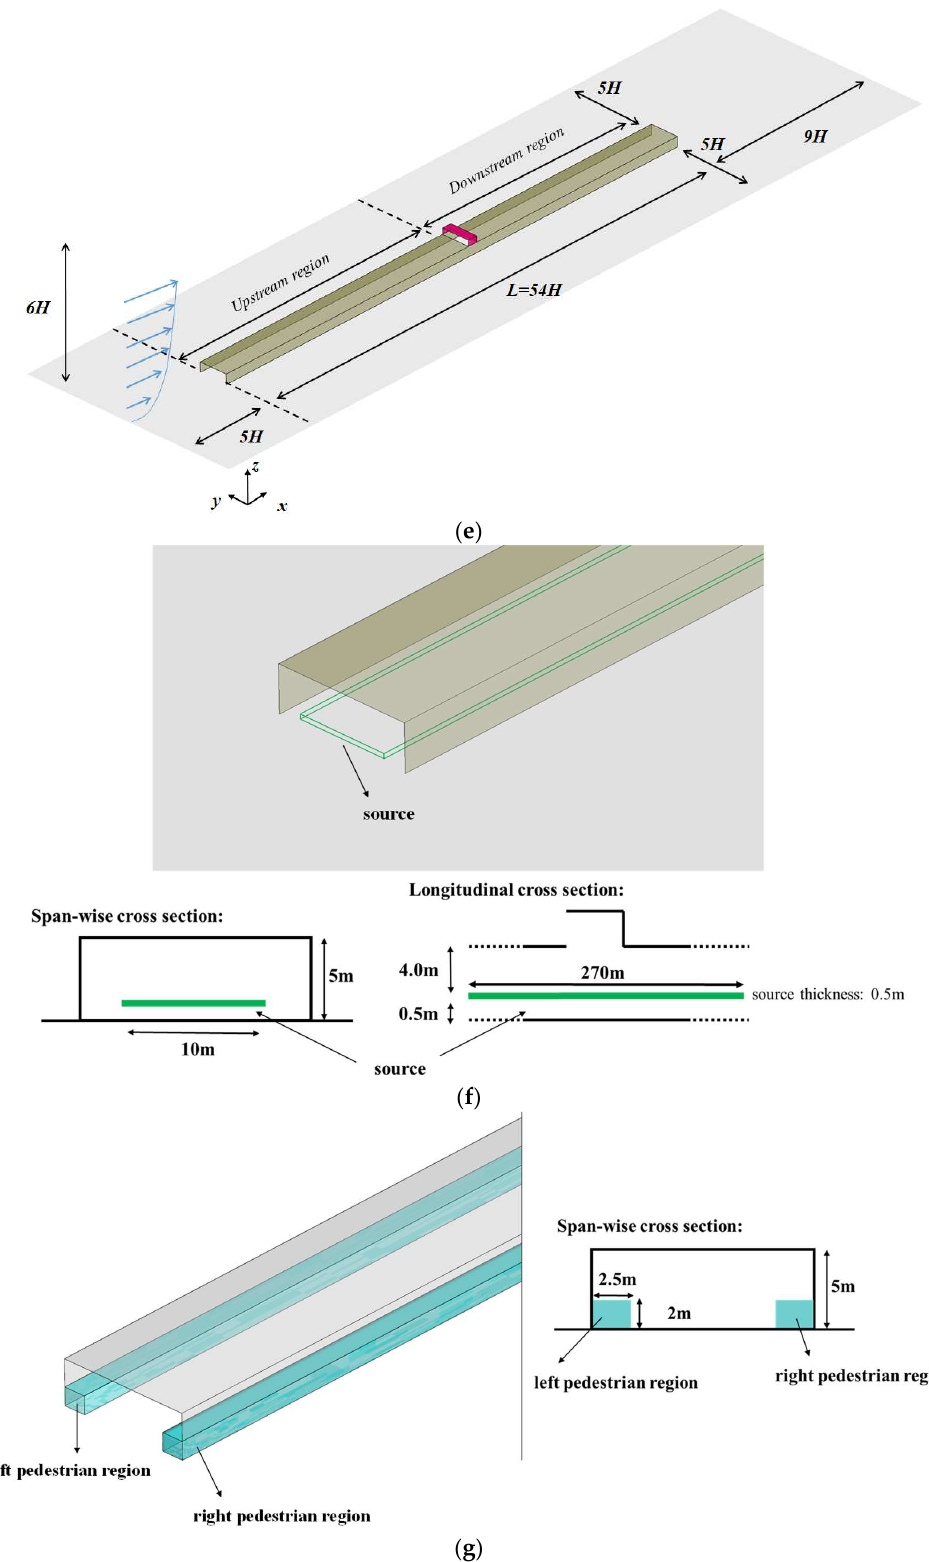
Figure 2. ( a ) Physical model and boundary condition setups in tunnel-catcher simulation cases. Model and grid distribution of ( b ) single long-catcher cases; ( c ) single short-catcher cases and ( d ) double short-catcher cases; ( e ) setup in computational domain; ( f ) source setup in cases; ( g ) setup of pedestrian regions.